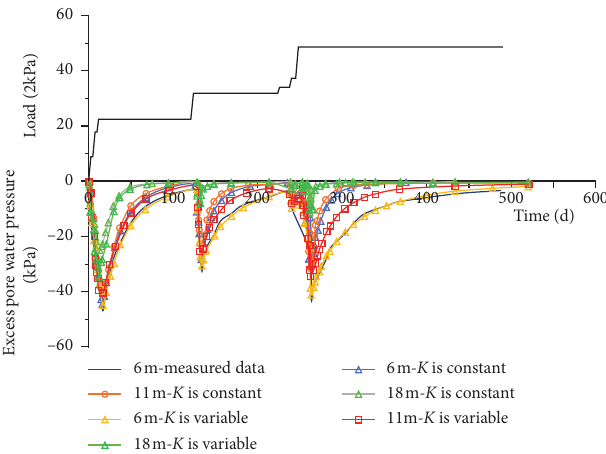
Figure 12: Comparison in soil excess pore water pressure at monitoring locations.